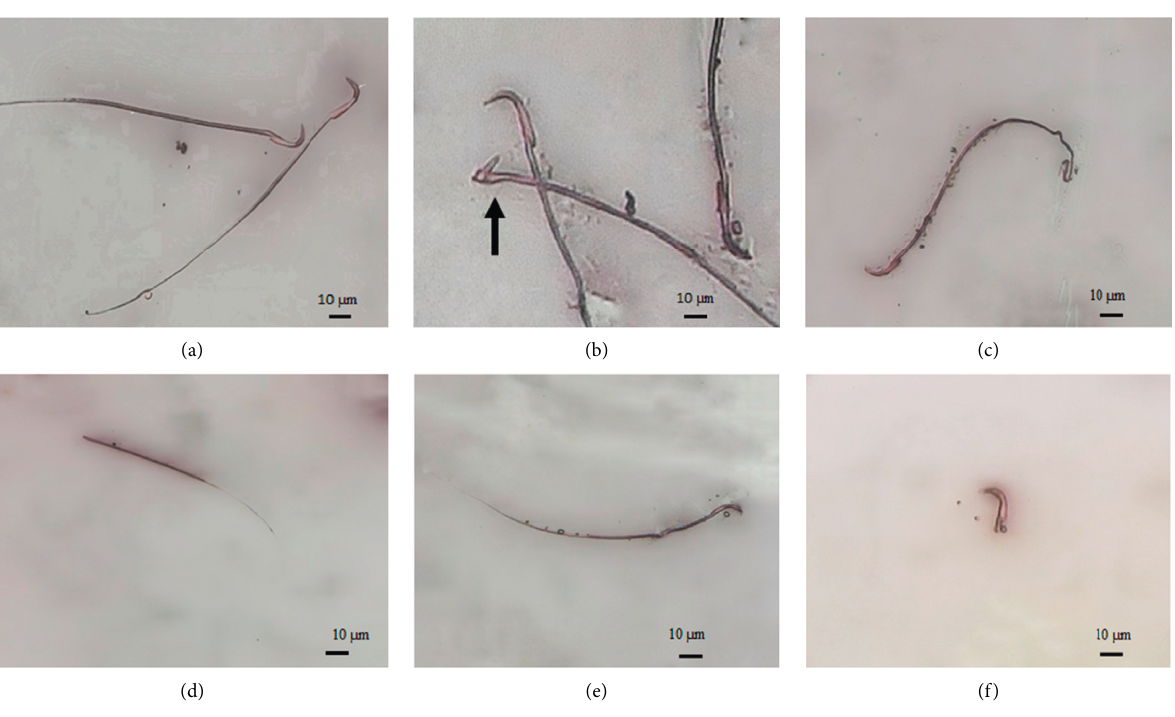
Figure 1: Sperm morphology of esomeprazole-treated rats at 2.5, 5, and 10mg/kg/day (40 x). (a) Normal sperm, (b) bent neck sperm, (c) bent tail sperm, (d) headless tail sperm, (e) banana head sperm, and (f) detached